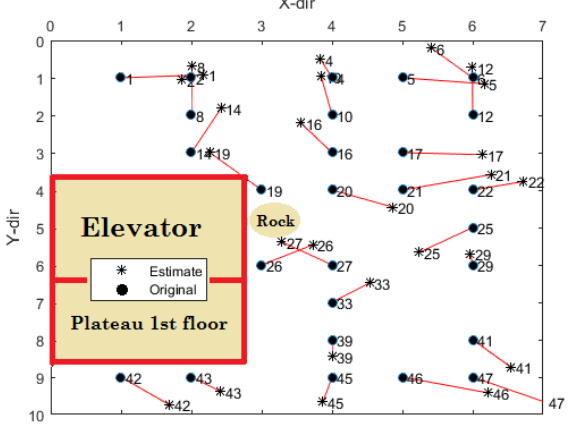
Figure 8. Top, precision of the design computations at z=1 in [m]. Bottom, the estimated precision by the BlooLoc IPS in